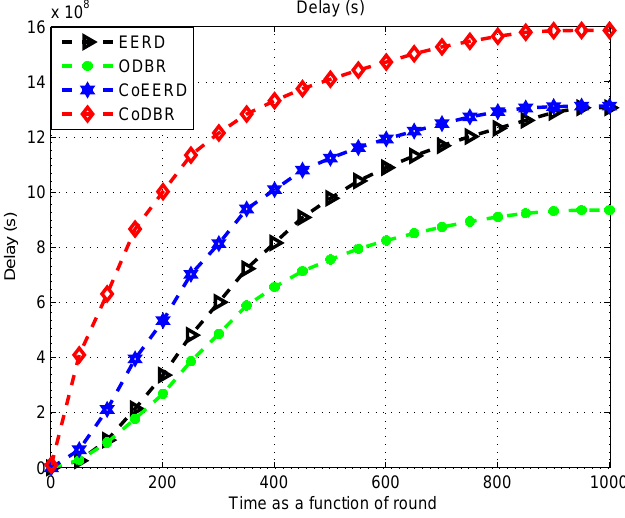
Figure 12. Total delay of the